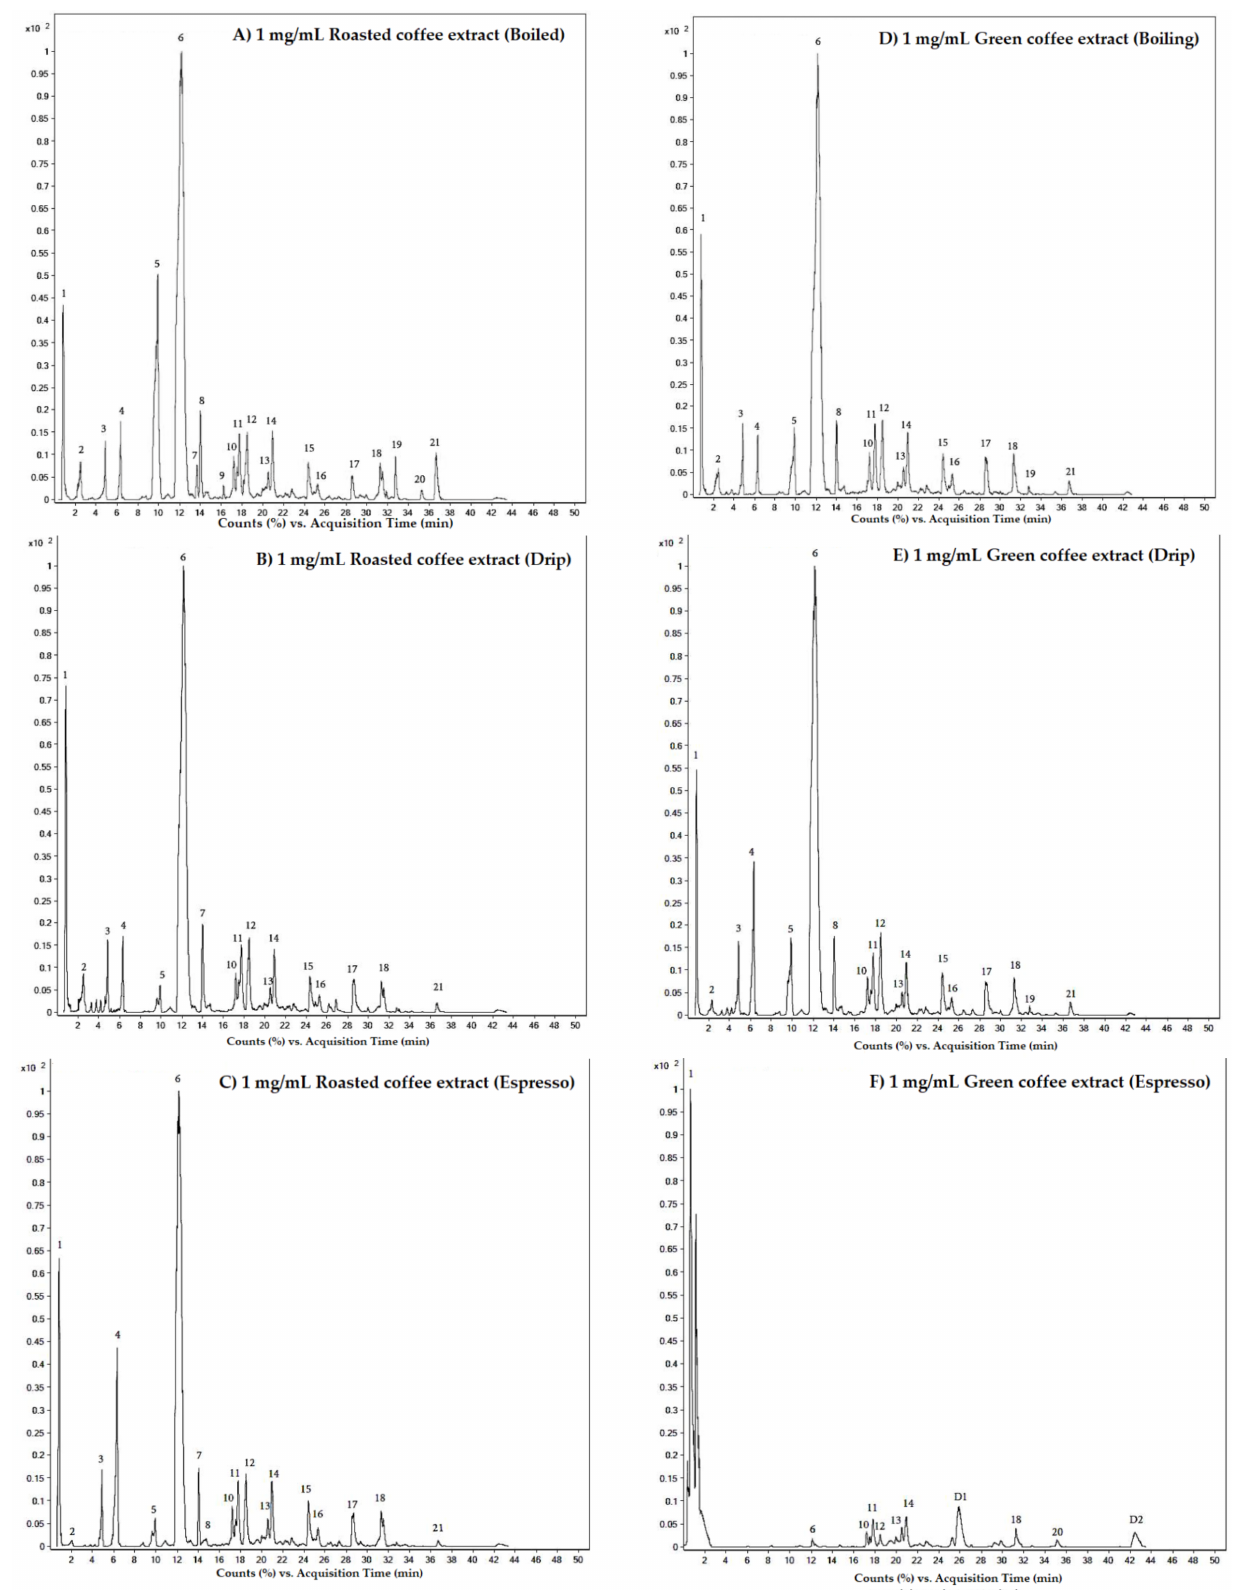
Figure 2. Chromatograms of the phytochemical compounds in roasted and green coffee extracts. Extracts of roasted coffee ( A – C ) and green coffee ( D – F ) were prepared by the boiling, drip and espresso methods, respectively. The coffee extracts were then identified using UHPLC-ESI-QTOF-MS, as has been described in Section